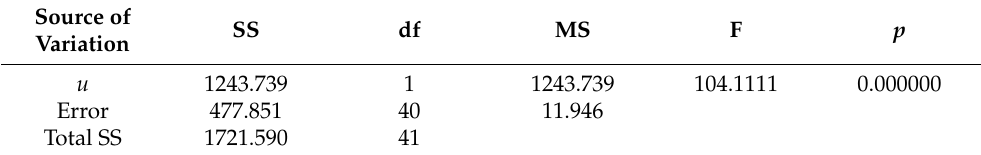
Table 15. Model of elongation at break ε —ANOVA table, R 2 = 0.72; R adj2 = 0.72. Source